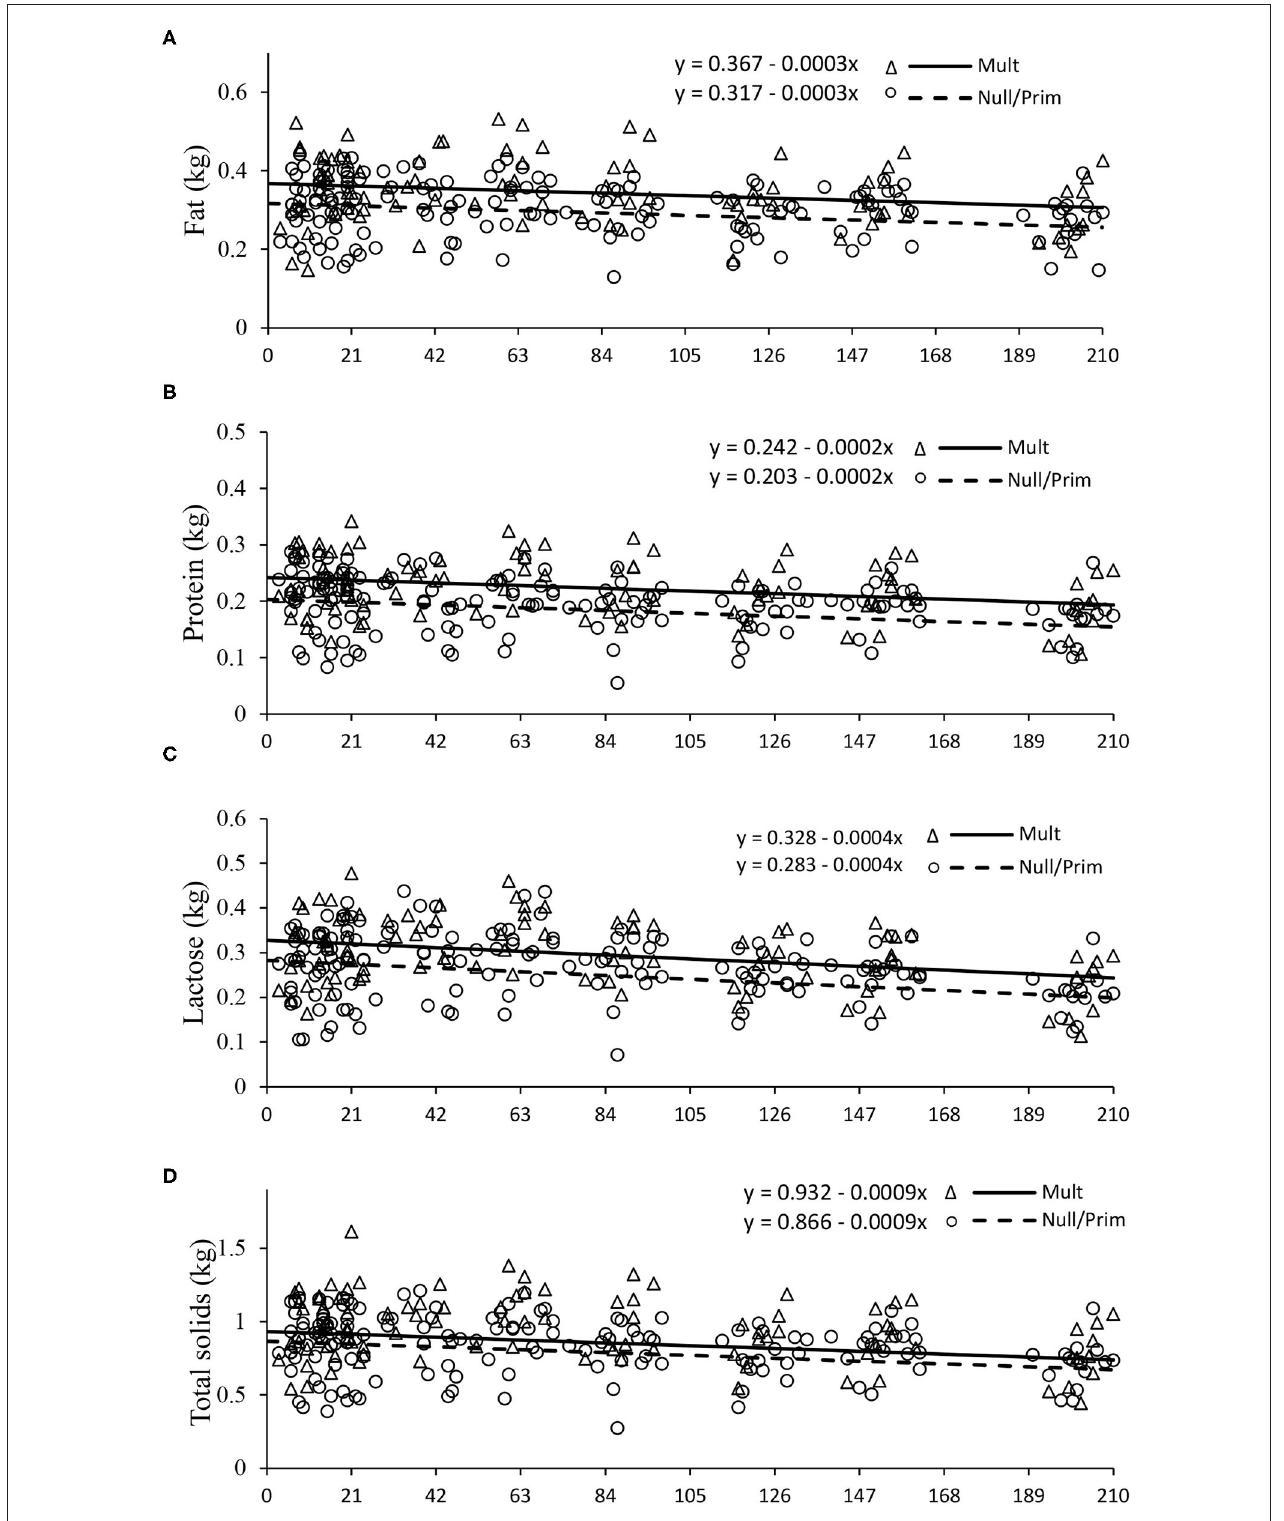
FIGURE 3 | Fat yield (A) , protein yield (B) , lactose yield (C), and total solids yield (D) of Nellore cows according to parity order under grazing. Mult (multiparous), Prim (primiparous), and Null (nulliparous).